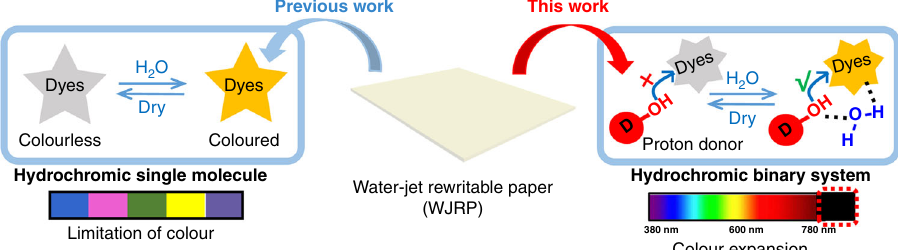
Fig. 1 Schematic illustration of different mechanism for water-jet rewritable paper (WJRP) between this work and our previous work. Mechanism of WJRP showing colour based on the hydrochromic single molecule in our previous work and the binary system in this work after addition of water